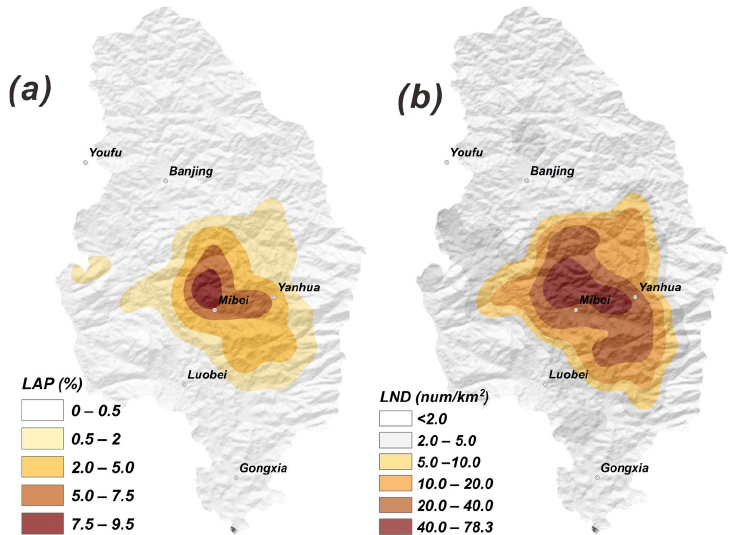
Figure 11. ( a ) Rainfall-induced landslide inventory of the 2019 heavy rainfall event in Longchuan County, the landslide abundance area of this event; ( b ) map showing the zooming of the landslide abundance area.